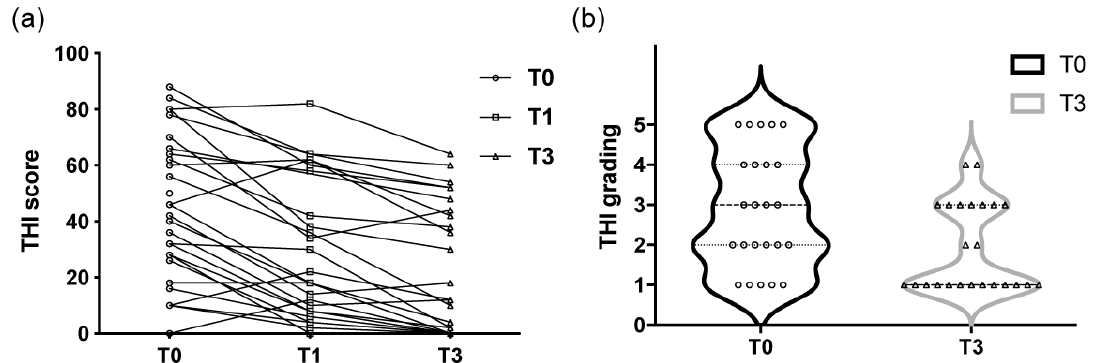
Figure 4. (a) The trends in each patient’s THI score over time. (b) THI grading before and after treatment; (T0) before treatment, (T1) 1 month after treatment, and (T3) 3 months after treatment. THI = Tinnitus Handicap Inventory.